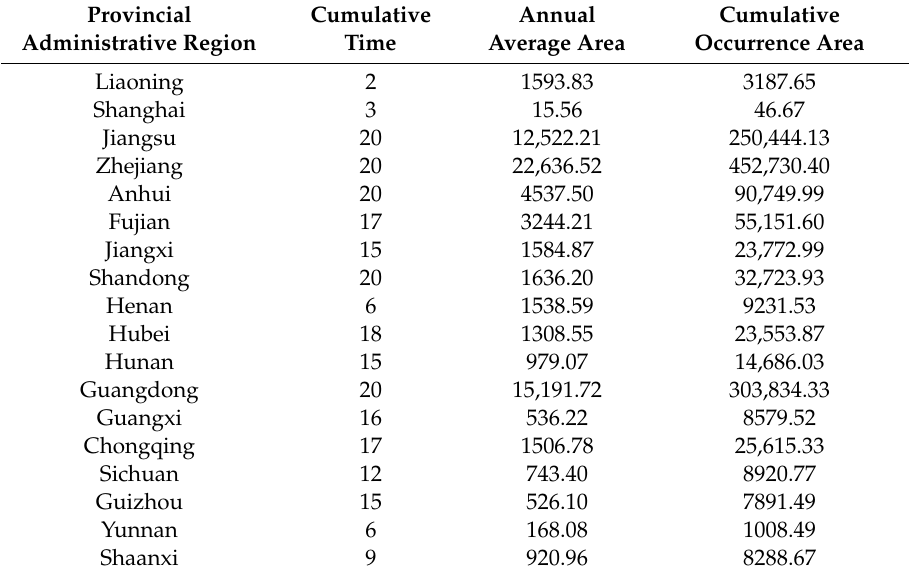
Table A2. The area of disease in provinces of mainland China from 1998 to 2017 / ha.